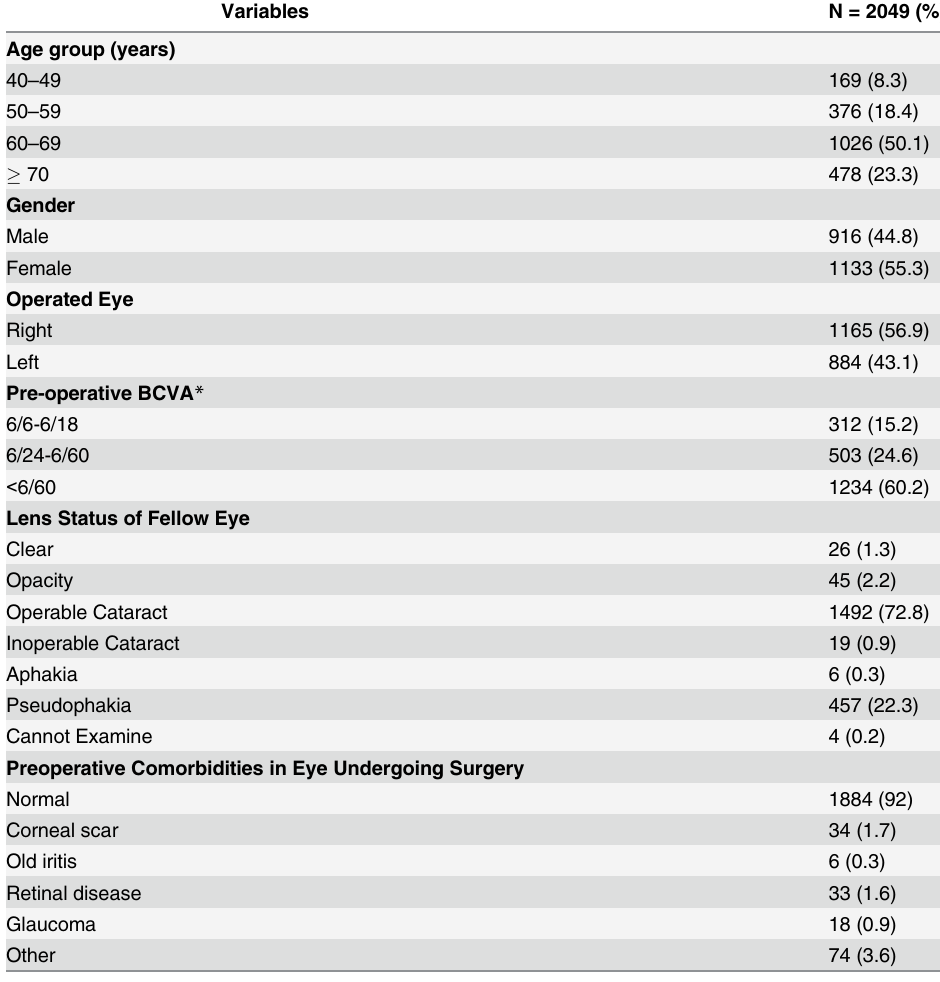
Table 1. Baseline demographic and ocular